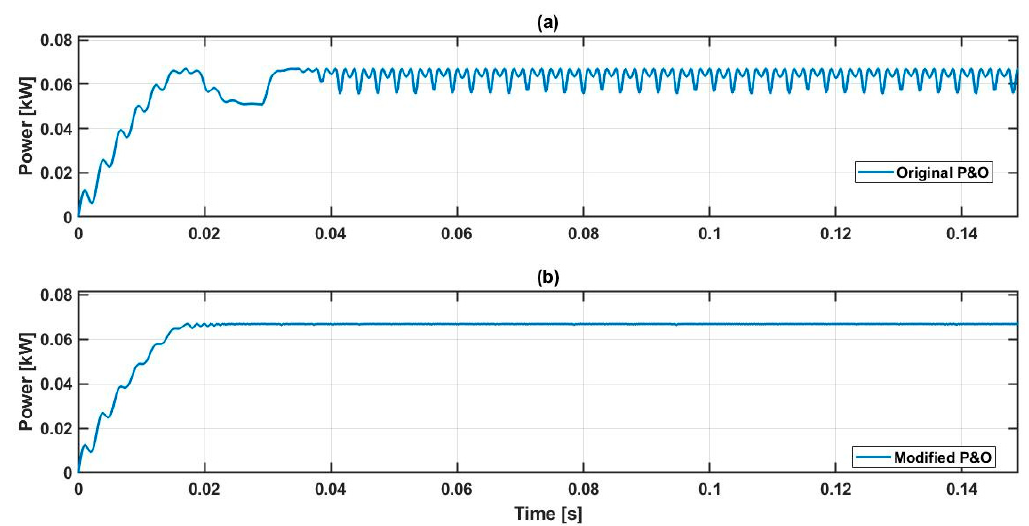
Figure 9. Low-power PV system response time and perturbations: ( a ) original P&O algorithm and ( b ) modified P&O algorithm.